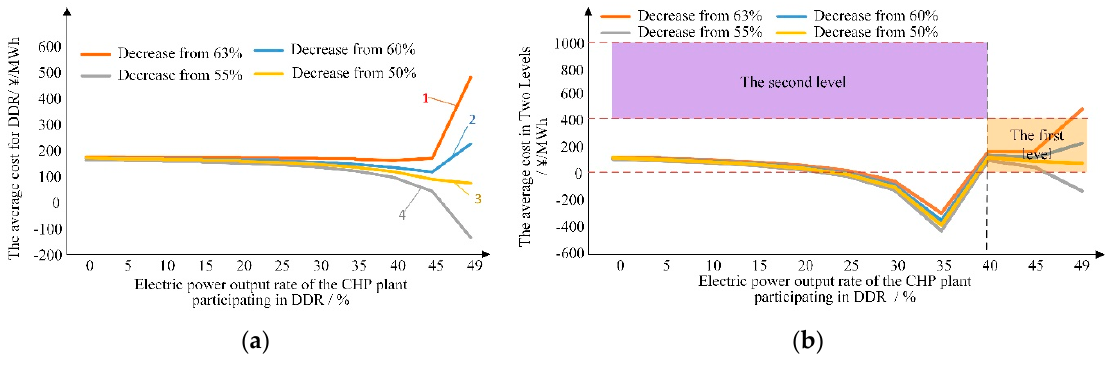
Figure 8. ( a ) The average cost for the DDR; ( b ) the average cost for DDR in two levels. According to Equations (21) and (22), the averages cost for DDR of the first level and the second level can be calculated under different approved power output rates, and the curve is shown in Figure 8b.